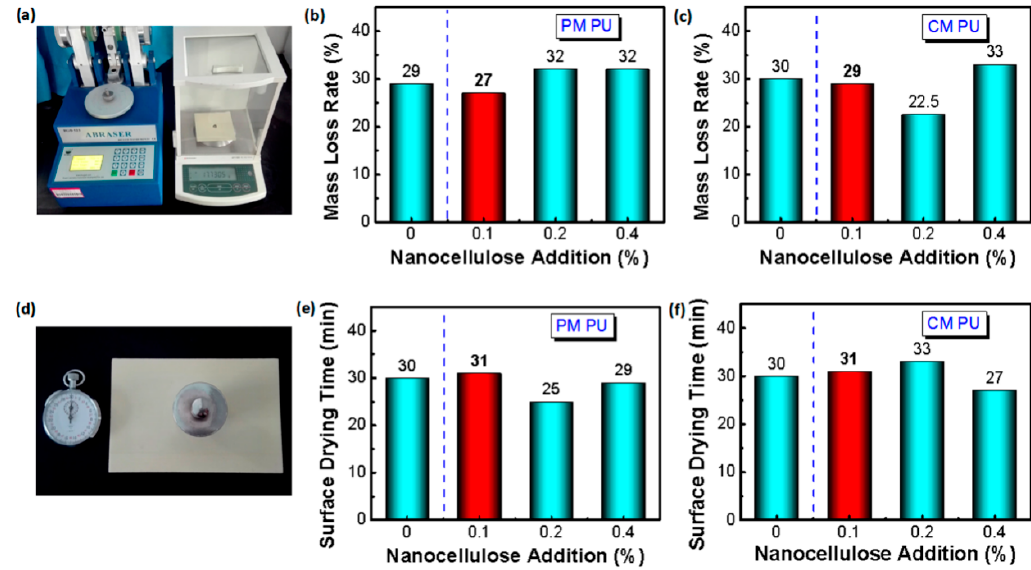
Figure 5. Comparison of abrasion resistance and surface drying time of the PU coatings. ( a ) Measurement of abrasion resistance of the PU coatings. (left: abrasion apparatus, right: electronic balance); ( b ) Comparison of abrasion resistance of PM PU coatings with different amounts of nanocellulose addition; ( c ) Comparison of abrasion resistance of CM PU coatings with different amounts of nanocellulose addition; ( d ) Measurement of surface drying time of the PU coatings. (left: clock, right: weight on the wood coating); ( e ) Comparison of surface drying time of PM PU coating with different amounts of nanocellulose addition; ( f ) Comparison of surface drying time of CM PU coating with different amounts of nanocellulose addition.